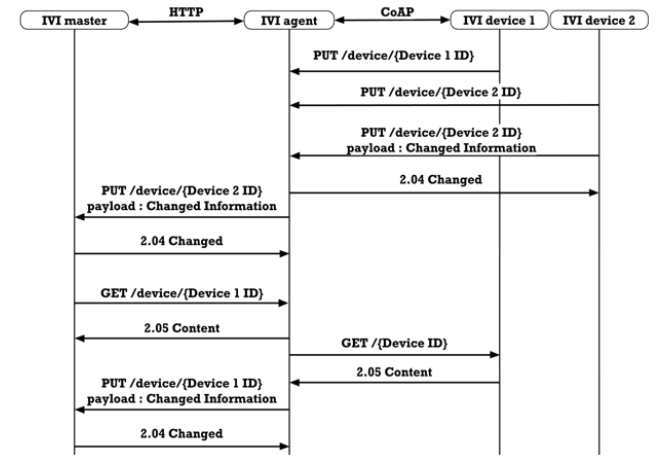
Figure 13. Operation flow for indirect communication.